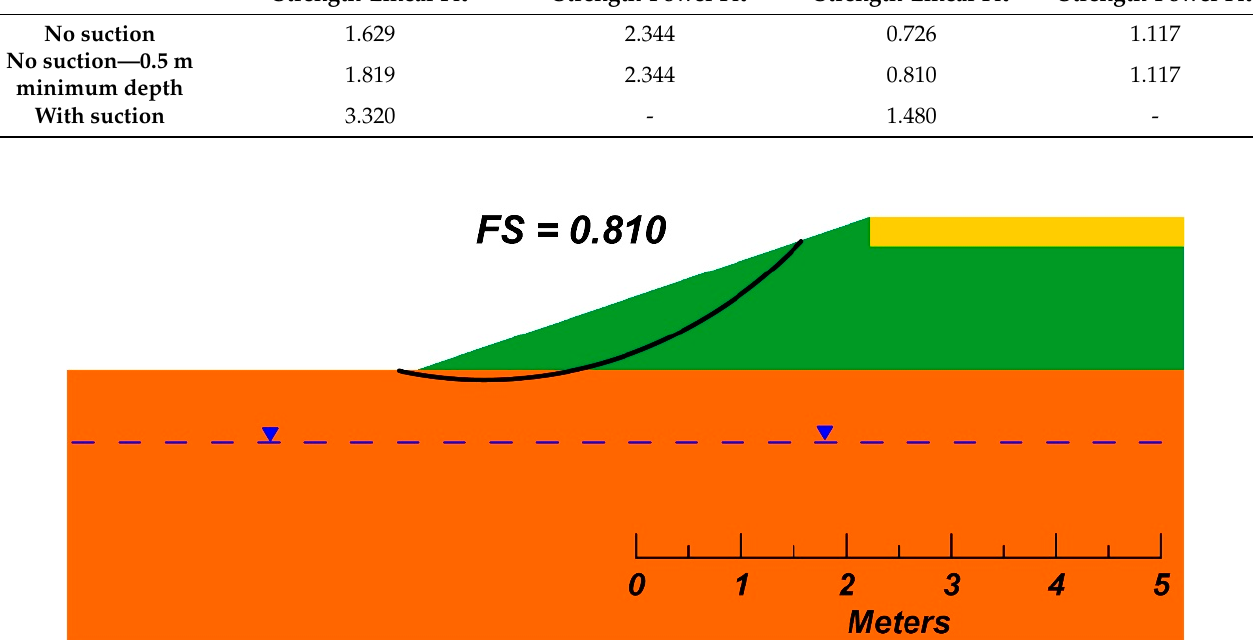
Figure 10. Slip surface for the residual shear strength estimated by the linear envelope without suction and a 0.5 m minimum